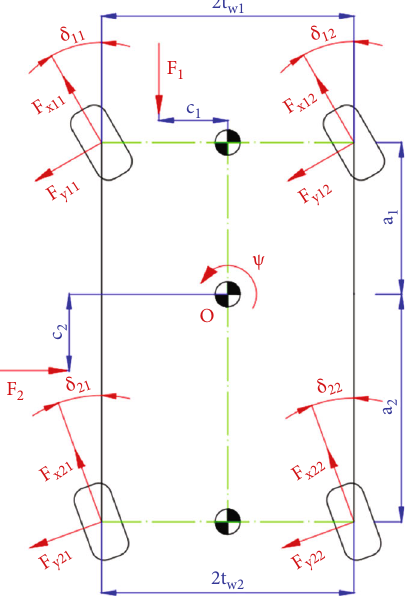
Figure 2: A model of the